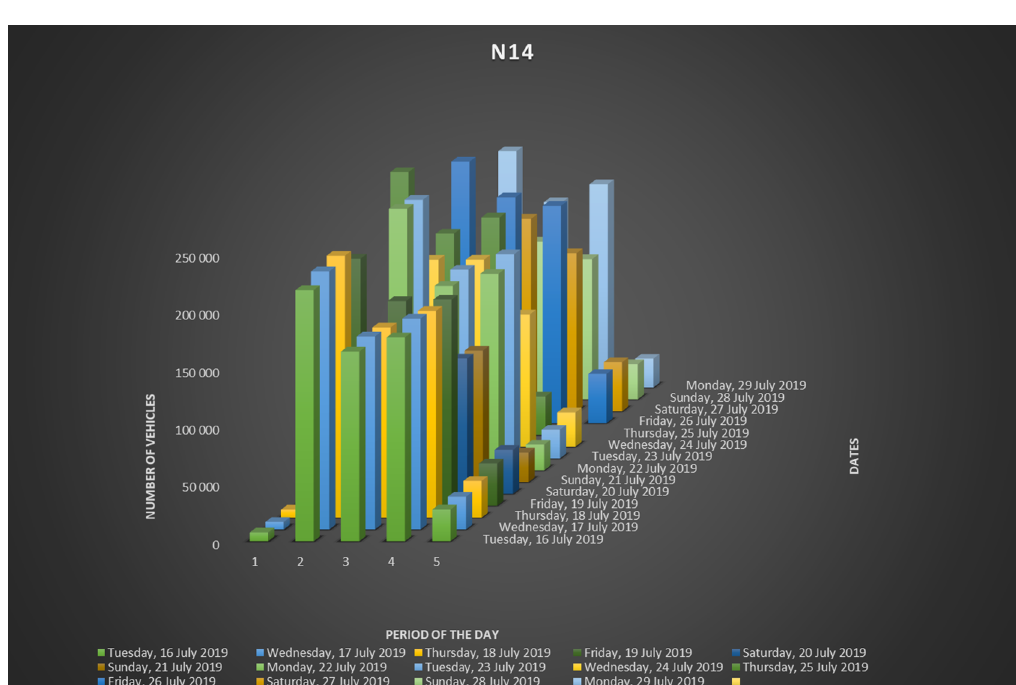
Figure A3. N12 freeway.